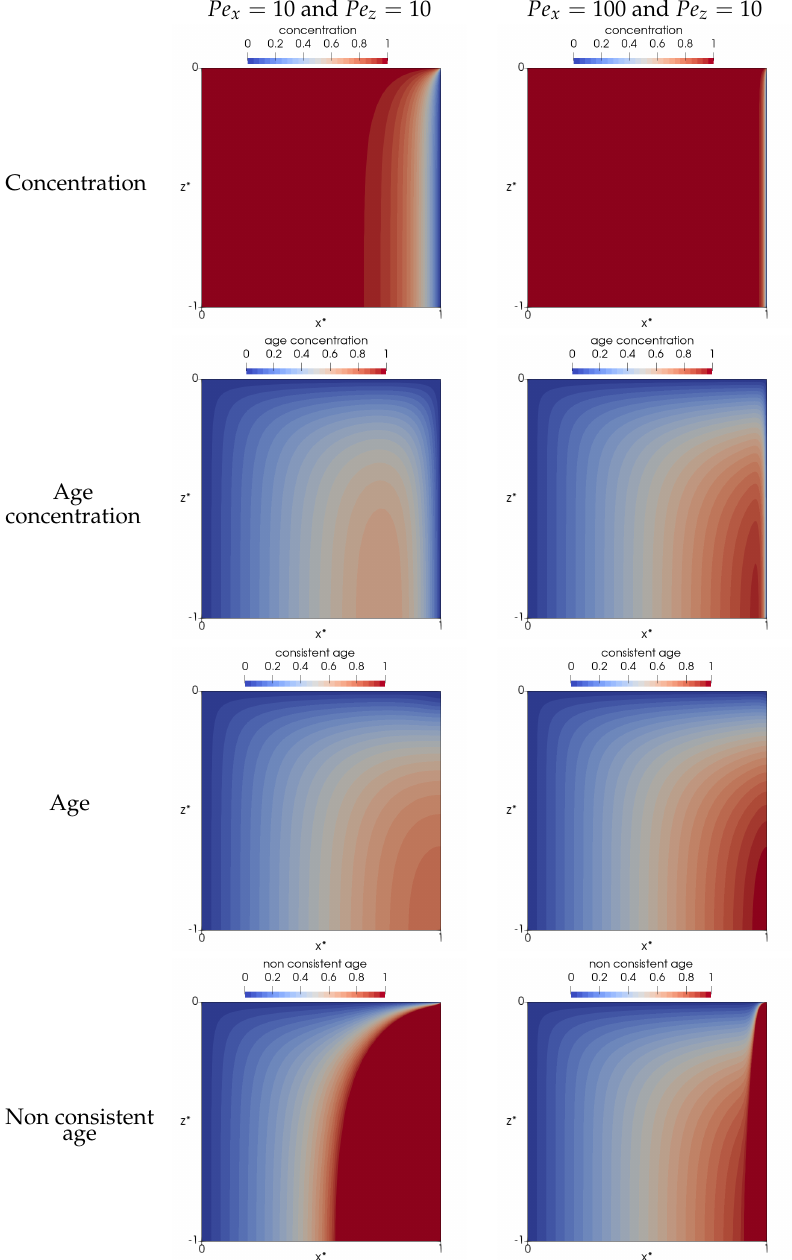
Figure 10. Illustration of the concentration, age concentration, and age from the solution of the partial differential problem (63) and (64) for ( Pe x , Pe z ) = ( 10,10 ) and ( Pe x , Pe z ) = ( 100,10 ) . Dimensionless variables are represented. They are identified by asterisks and are defined as follows: x ∗ = x / L , z ∗ = z / h , α ∗ = U α / L , and a ∗ = Ua / L . The non-consistent age ensuing from inappropriate boundary conditions for the age concentration on the departure boundary is represented in the lowermost row of the